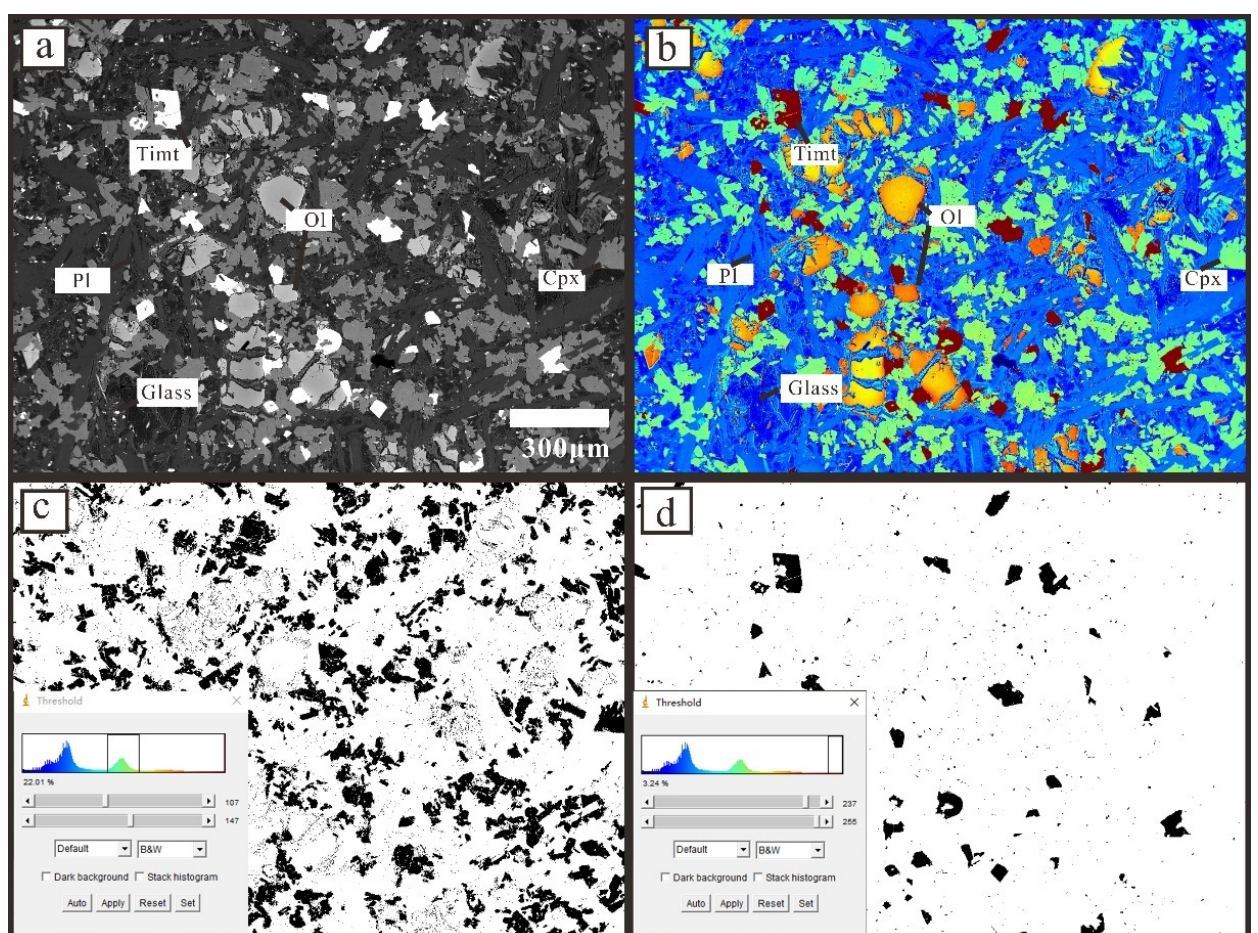
Figure 2. An example (17XHK01) of distinguishing all minerals and obtaining their contents. ( a ): BSE photograph of 17XHK01; ( b ): Jet color is given to the BSE grayscale photograph to make it easier to use ImageJ Threshold to distinguish different minerals; ( c ): The outlines of clinopyroxene using ImageJ Threshold; ( d ): The outlines of titanomagnetite using ImageJ Threshold.Pl: Plagioclase, Cpx: Clinopyroxene, Timt: Titanomagnetite, Ol: Olivine. The mineral symbols are referred to as Warr [84].